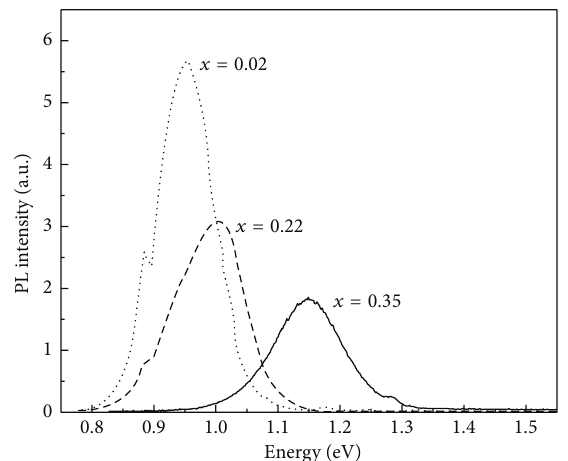
Figure 3: PL spectra for CuIn 1− for 60 min, for different gallium concentration ( x = 0.02, 0.22, and 0.35). Measurements were conducted at 77 K, using a 5 mW laser at an excitation wavelength of 514.5 nm. The increase of the broadband peak position with increasing gallium content (increase in x ) is observed.